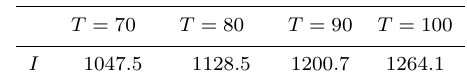
Analysis of maximal values of electrical current: I denotes the largest possible value of electrical current, T denotes the threshold value of